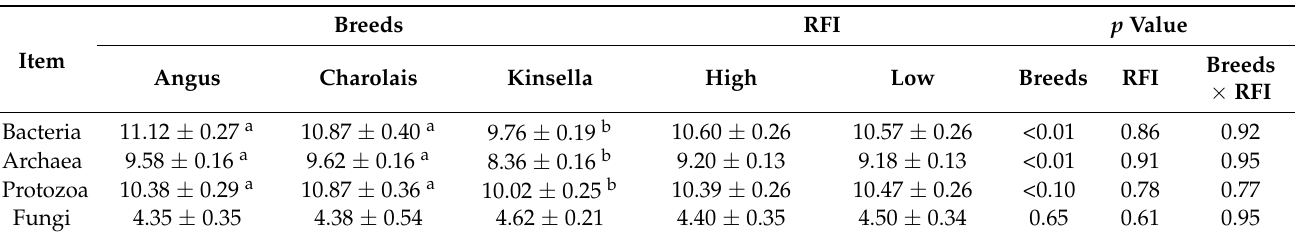
Table 4. Effects of breed and divergent RFI on the log-transformed marker gene transcript copies (g − 1 rumen content) of the targeted rumen microbial groups at the RNA